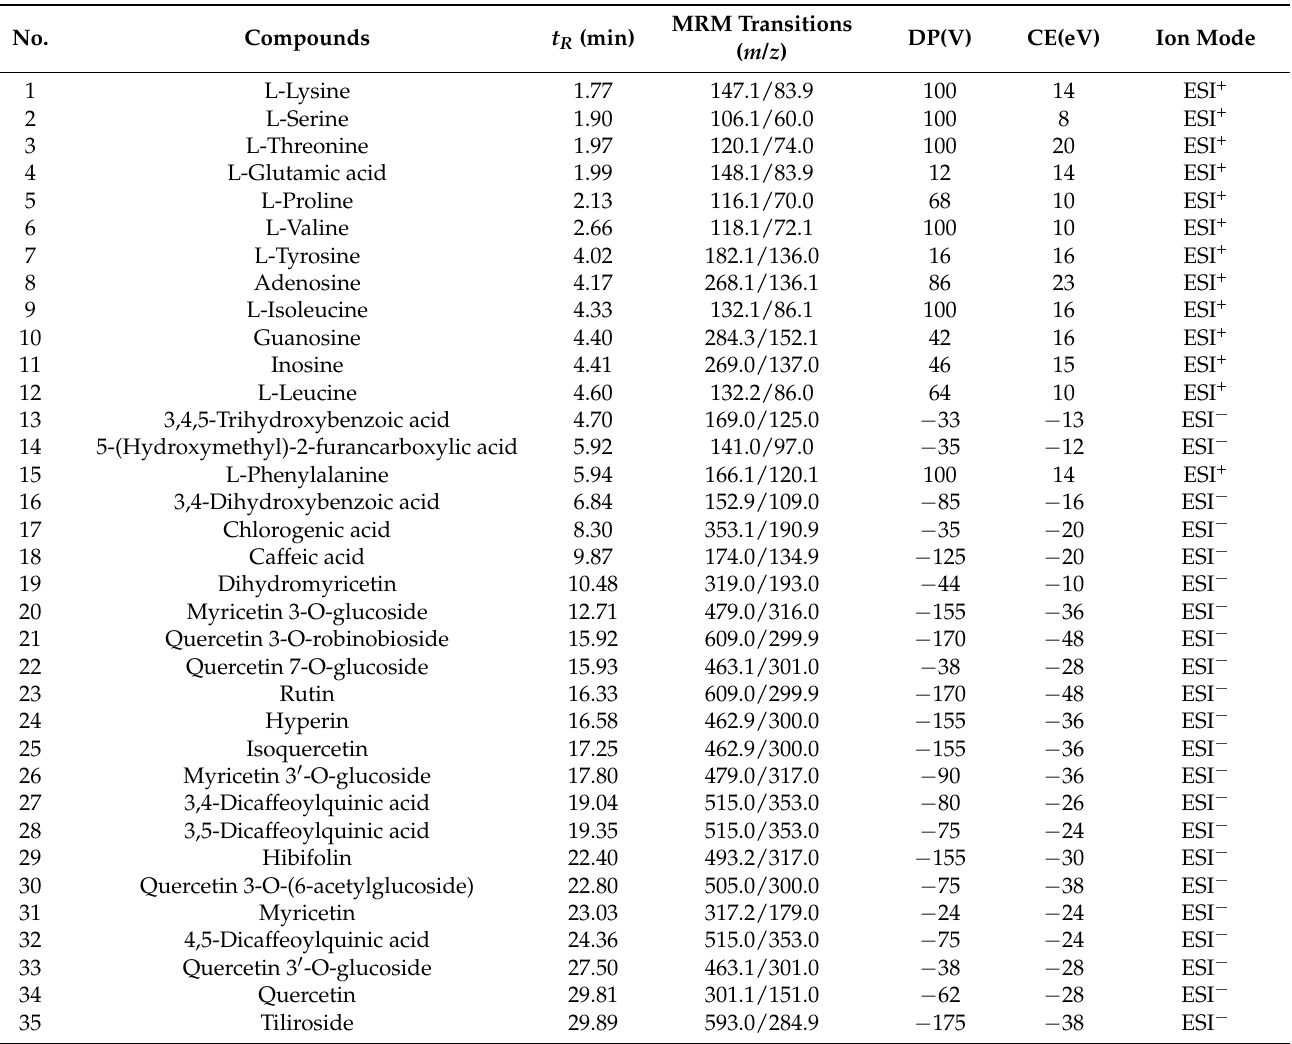
Table 1. Retention time, related mass spectrometric data of the 35 target